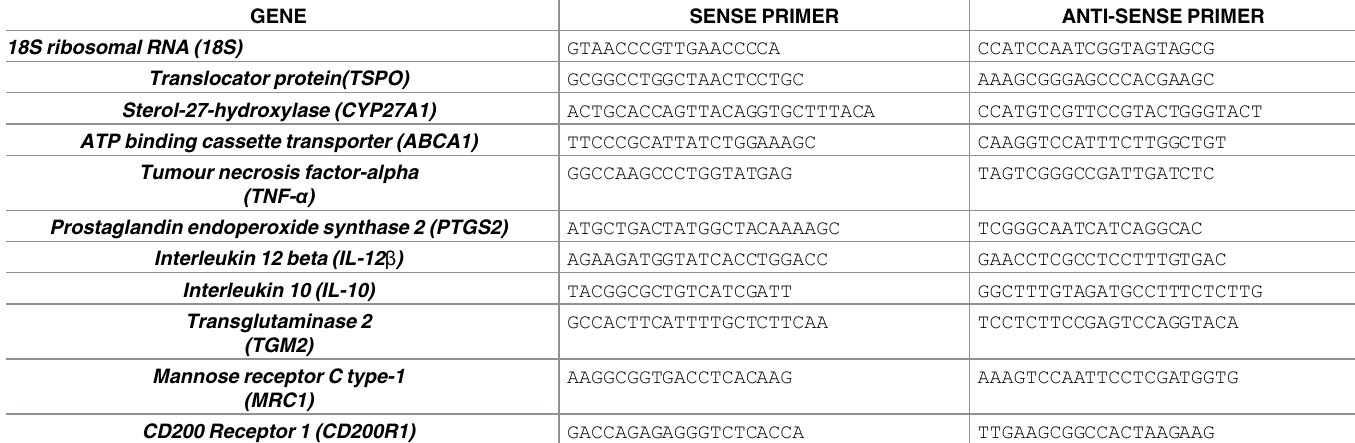
Table 1. Primers used for real-time